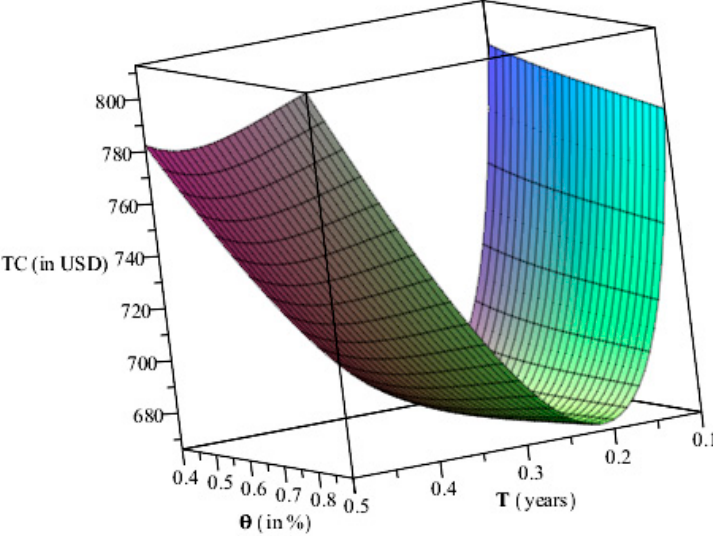
Figure 8. The total cost function’s convexity behavior for α < 0 and c p < h c